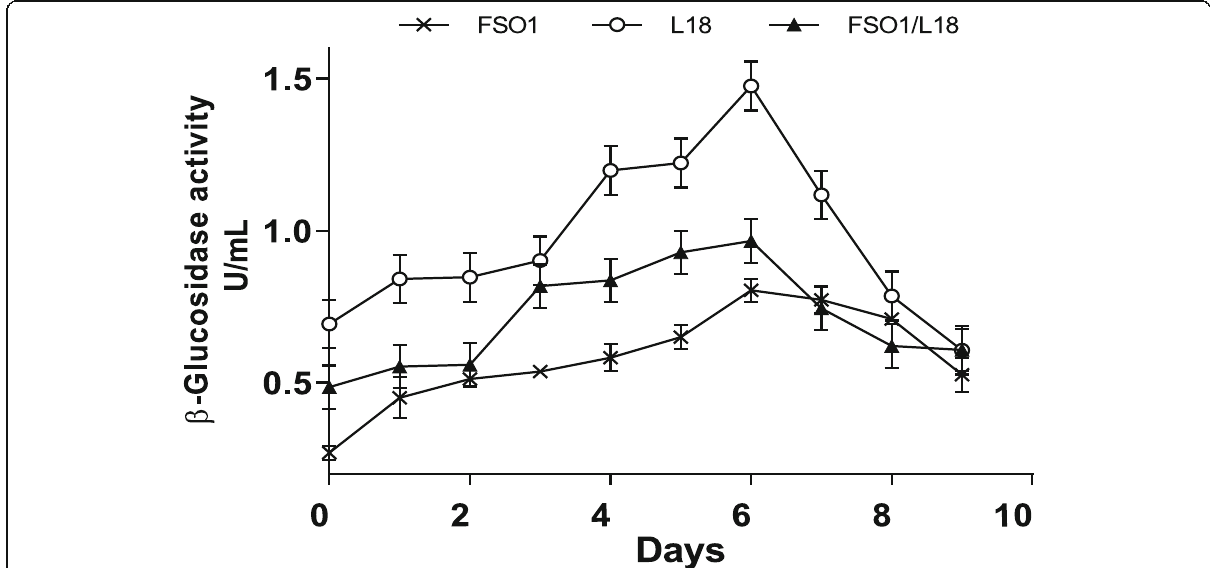
Fig. 6 β -Glucosidase activity of pure (FSO1, L18) and combined (FSO1/L18) cultures during 9 days of incubation at 30 °C in modified MRS broth containing oleuropein (1%) as a sole carbon source. (Legend: FSO1: L. plantarum , L18: C. pelliculosa